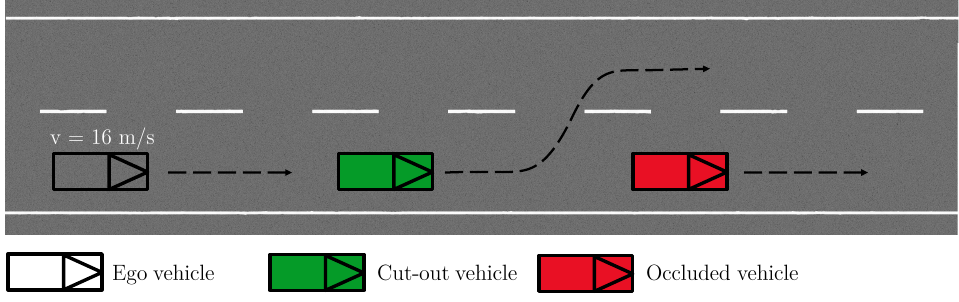
Figure 12. Overview of the original motorway scenario for the standard ODD of the ALKS (adapted cut-in scenario from [71]).